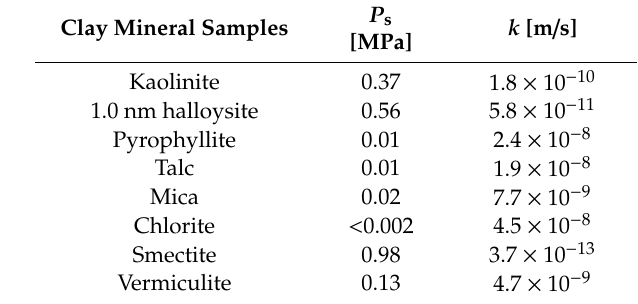
Table 2. Swelling pressure ( P s ) and average hydraulic conductivity ( k ) of clay mineral powder samples (void ratio = 0.95).